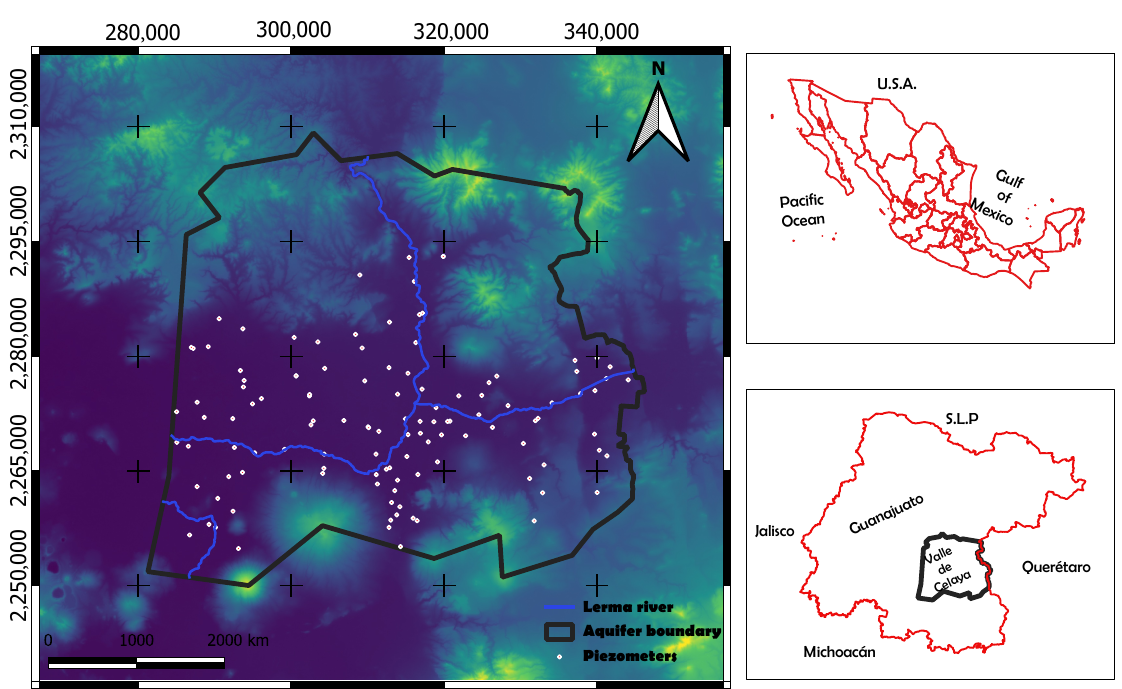
Figure 1. Location of the Celaya Valley aquifer, Guanajuato, Mexico. Topographic map of the Figura 1.1: Localizaci´on del acu´ıfero Valle de Celaya.